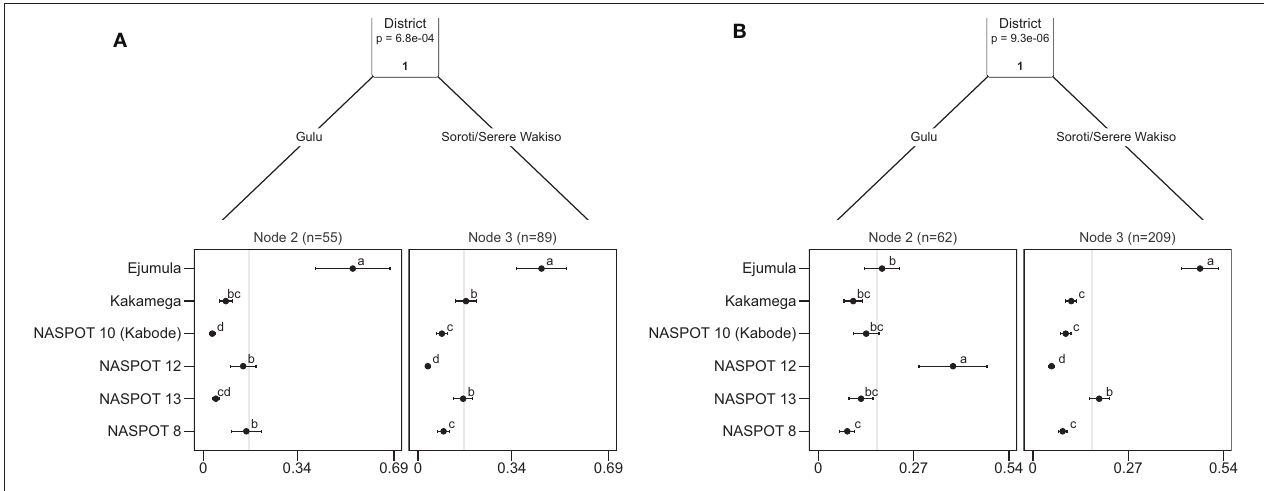
FIGURE 8 | Plackett-Luce Tree of crowdsourcing citizen-science evaluation on sweetpotato genotypes in (A) Centralized tasting and (B) Home tasting in Uganda. The horizontal axis of each panel represents the probability of winning for the genotypes. Error bars show quasi-SEs. The gray vertical line indicates the average probability of winning (1/number of genotypes). In this case, the model selected the district as the splitting covariate. Different letters indicate significant differences at p <